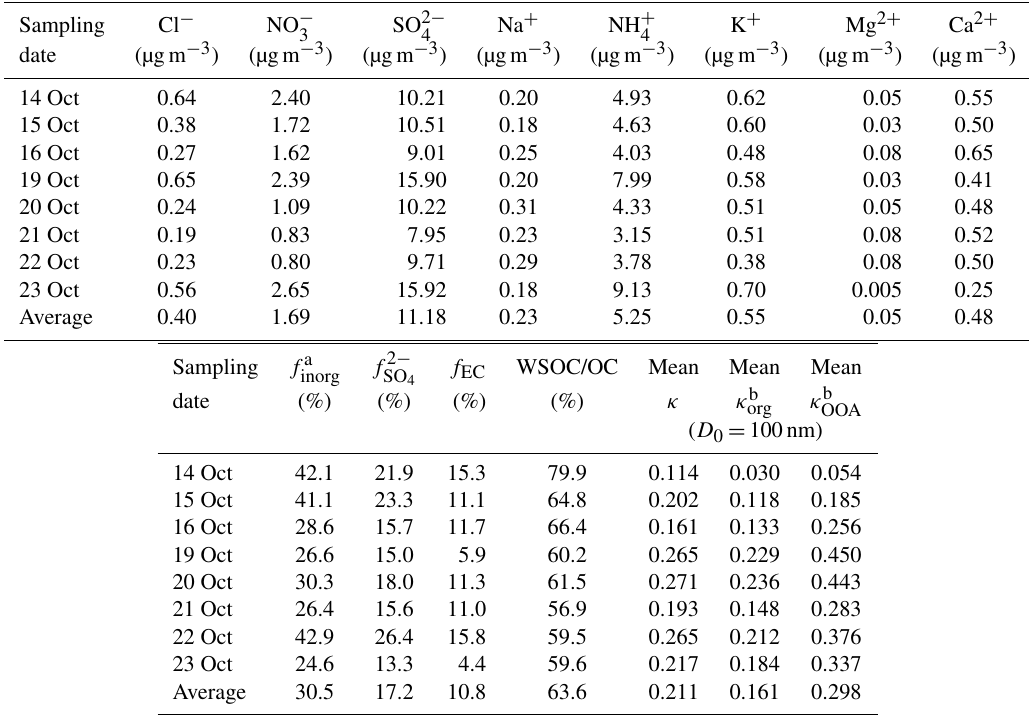
Table 2. Summary of the averaged chemical characteristics of the 24h PM 2 . 5 filter samples collected during 2015 haze events and the accordingly calculated mean κ results of organics (RH =